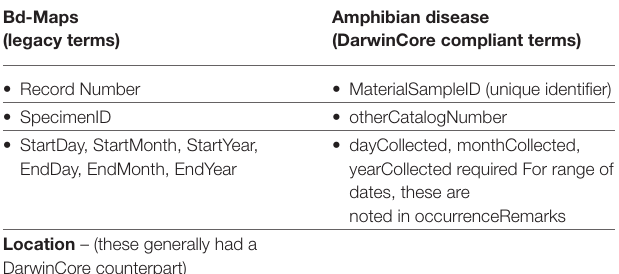
TABLE 1 | Comparison of terms in legacy and current